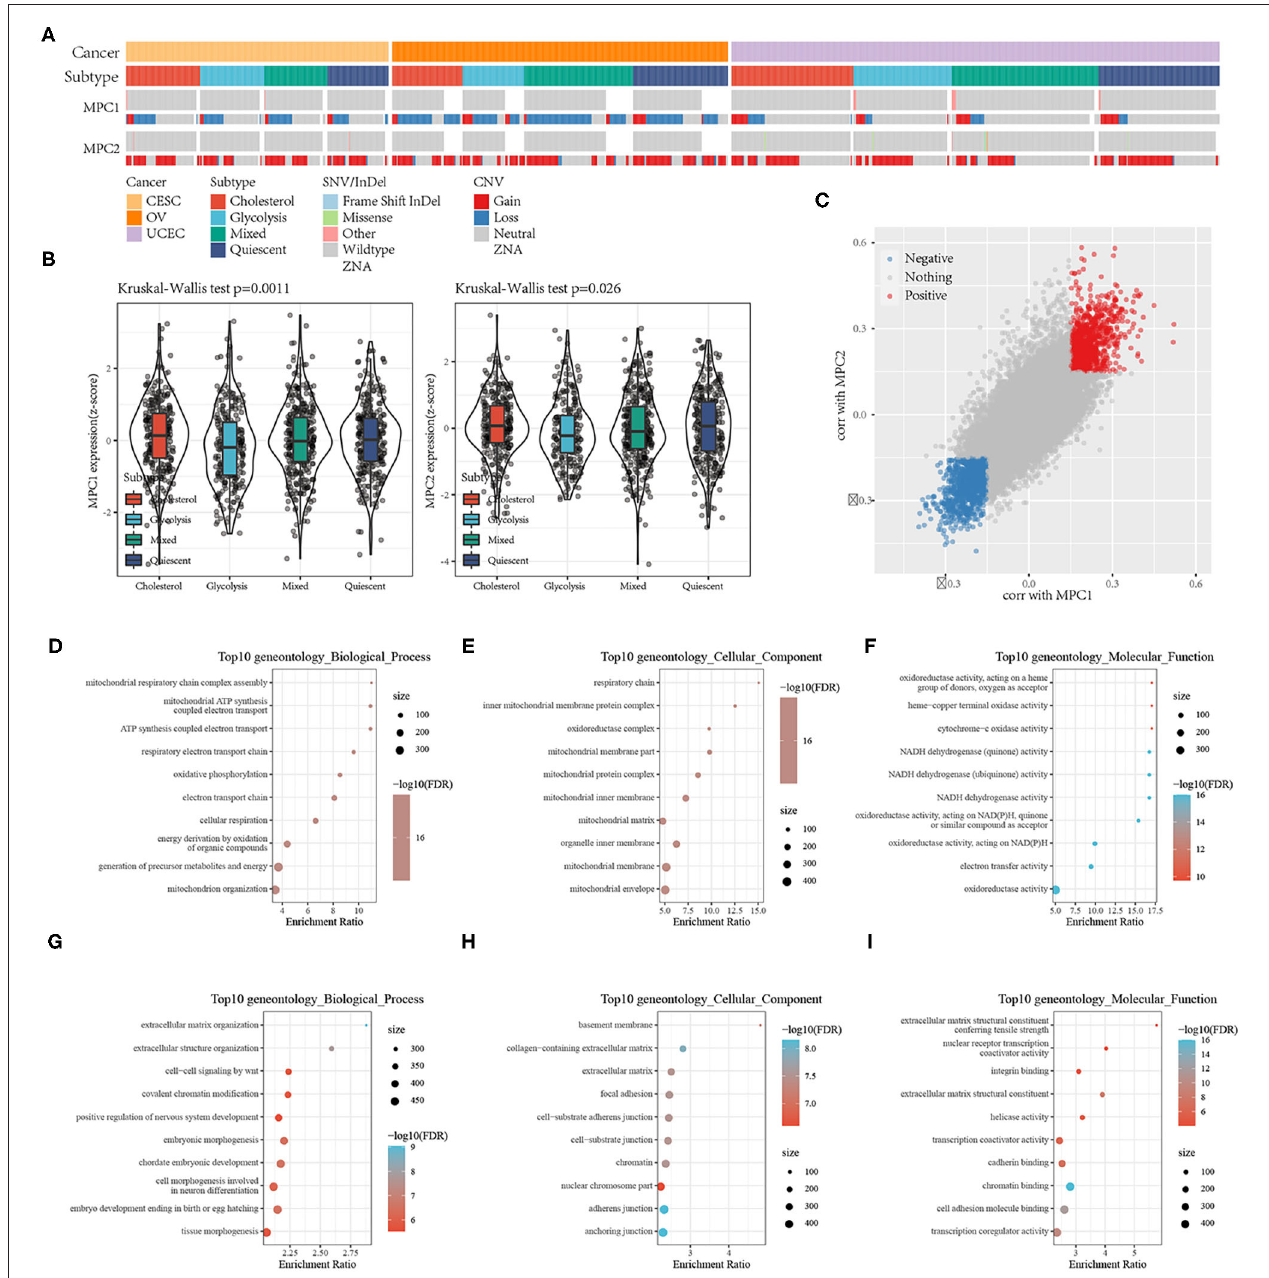
FIGURE 4 | (A) Mutations and CNV distribution of MPC1/2 in different metabolic subtypes; (B) Comparison of MPC1/MPC2 expression between different metabolic subtypes; (C) Scatter plot of MPC1/MPC2 related genes; (D–F) GO Functional annotation of genes positively related to MPC1/2; (G–I) GO Functional annotation of genes negatively associated with